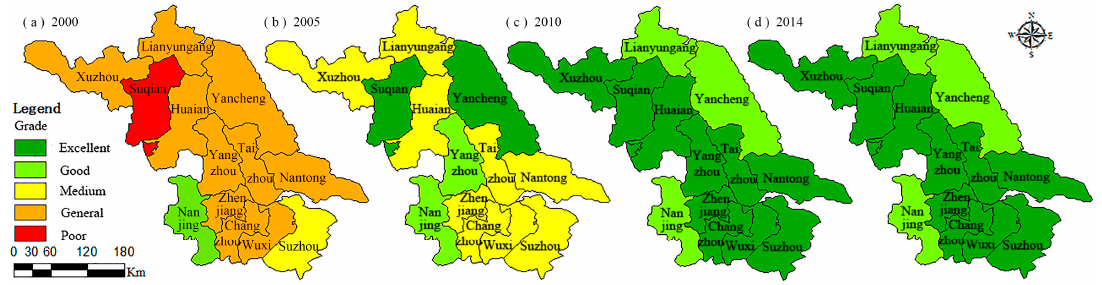
Figure 2. UEH status of Jiangsu province within different years: ( a ) 2000, ( b ) 2005, ( c ) 2010, ( d ) 2014.